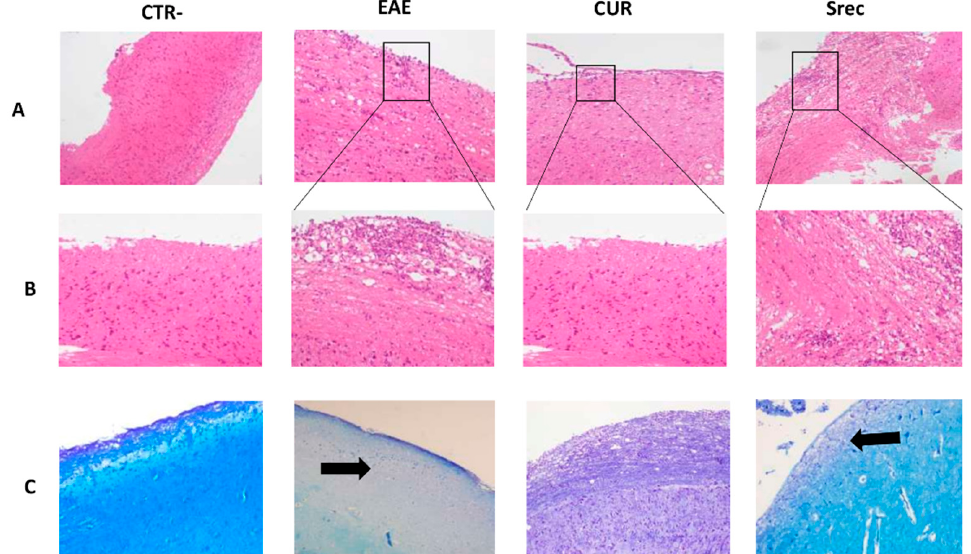
Figure 4. Effect of curcumin on the inflammation and demyelination in the spinal cord of EAE mouse. ( A ) Hematoxylin and eosin staining for assessment of inflammation (Obj × 10). ( B ) Boxes in Figure 4A show magnified images of inflamed region (Obj × 20). Higher inflammatory cell infiltration was observed in the EAE group when compared to CTR- animals; Cur alleviated inflammation when compared to the EAE and Srec groups ( C ). Representative micrographs prepared from the spinal cords of all groups, stained with luxol fast blue (Obj × 10). Arrows show magnified images of demyelinated areas; 10 sections from each group were scored.